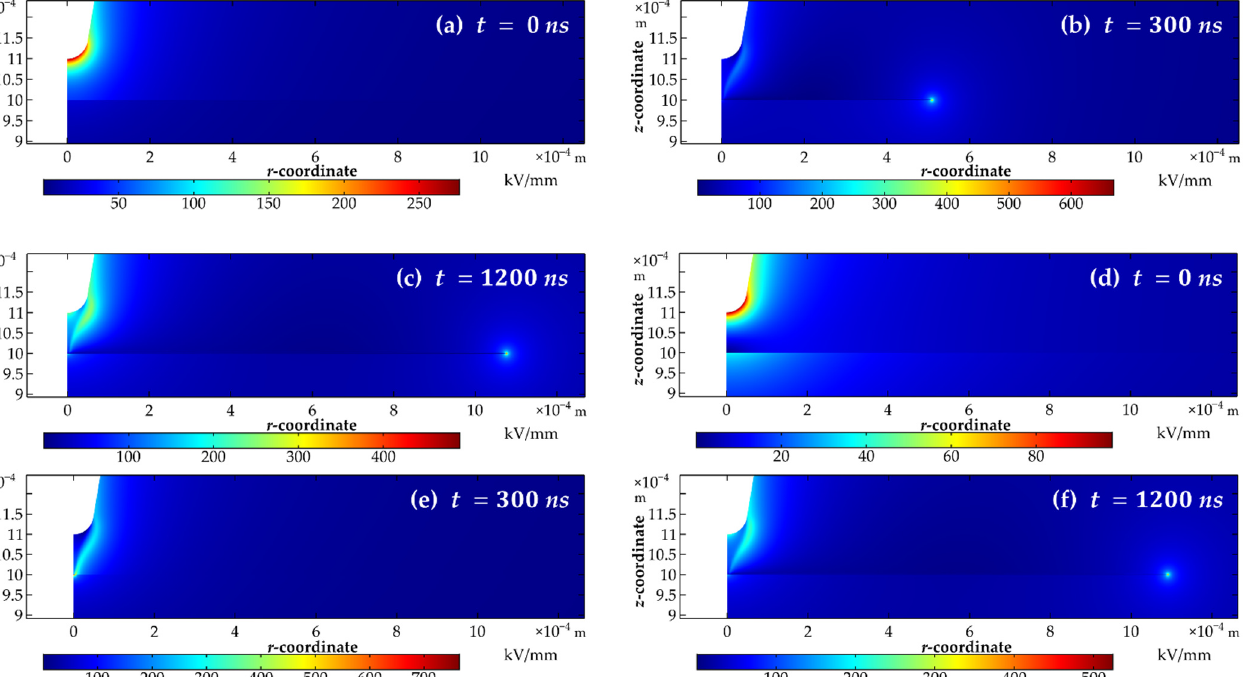
Figure 13. Streamer velocity (km/s) as a function of time (ns) in the 1st case: ( a ) streamer propagation in oil; ( b ) streamer travel along the oil–OIP interface.